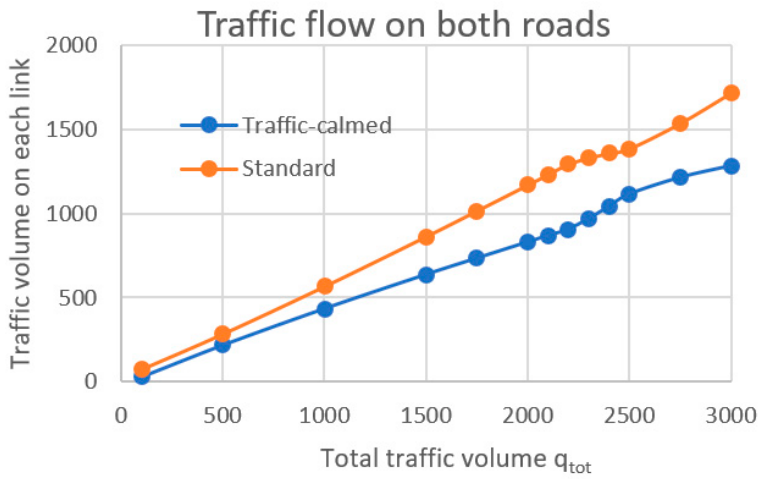
Figure 16. Traffic flow on both roads according to the total traffic volume, source: